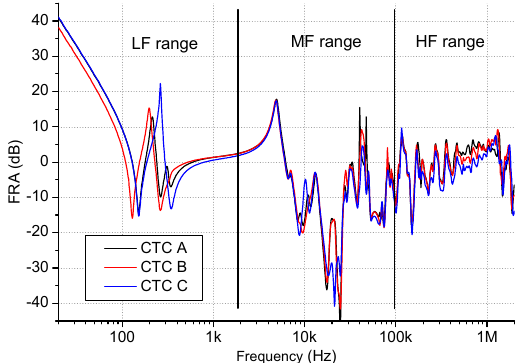
Figure 2. CTC graph obtained from data presented on Figure 1.